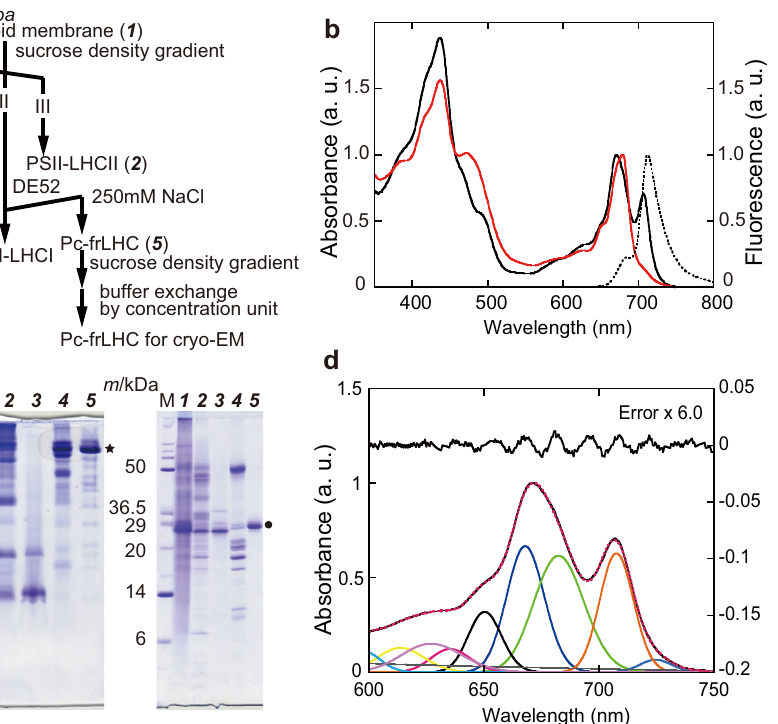
Fig. 1 | Puri fi cation of Pc-frLHC. a Puri fi cation scheme of Pc-frLHC and other photosynthetic proteins from P. crispa ’ s thylakoid membranes. b Absorbance spectra(solidlines)and fl uorescencespectrum(dottedline)ofthethylakoids(red) and Pc-frLHC (black) measured at room temperature. c hrCN-PAGE (left) and SDS- PAGE (right) analyses of thylakoids (lane 1), PSII-LHCII (lane 2), LHCII (lane 3), PSI- LHCI (lane 4), and Pc-frLHC (lane 5). Lane numbers at the top of the gel images correspondtotheitalicizednumbersinparenthesesin( a ).Bandscorrespondingto Pc-frLHC and the subunit of Pc-frLHC are indicated by the star and the bullet, respectively. These electrophoresis data were representative of two independent